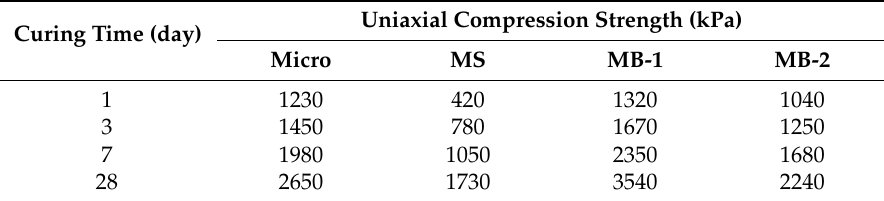
Table 5. Uniaxial compression strengths of the improved micro